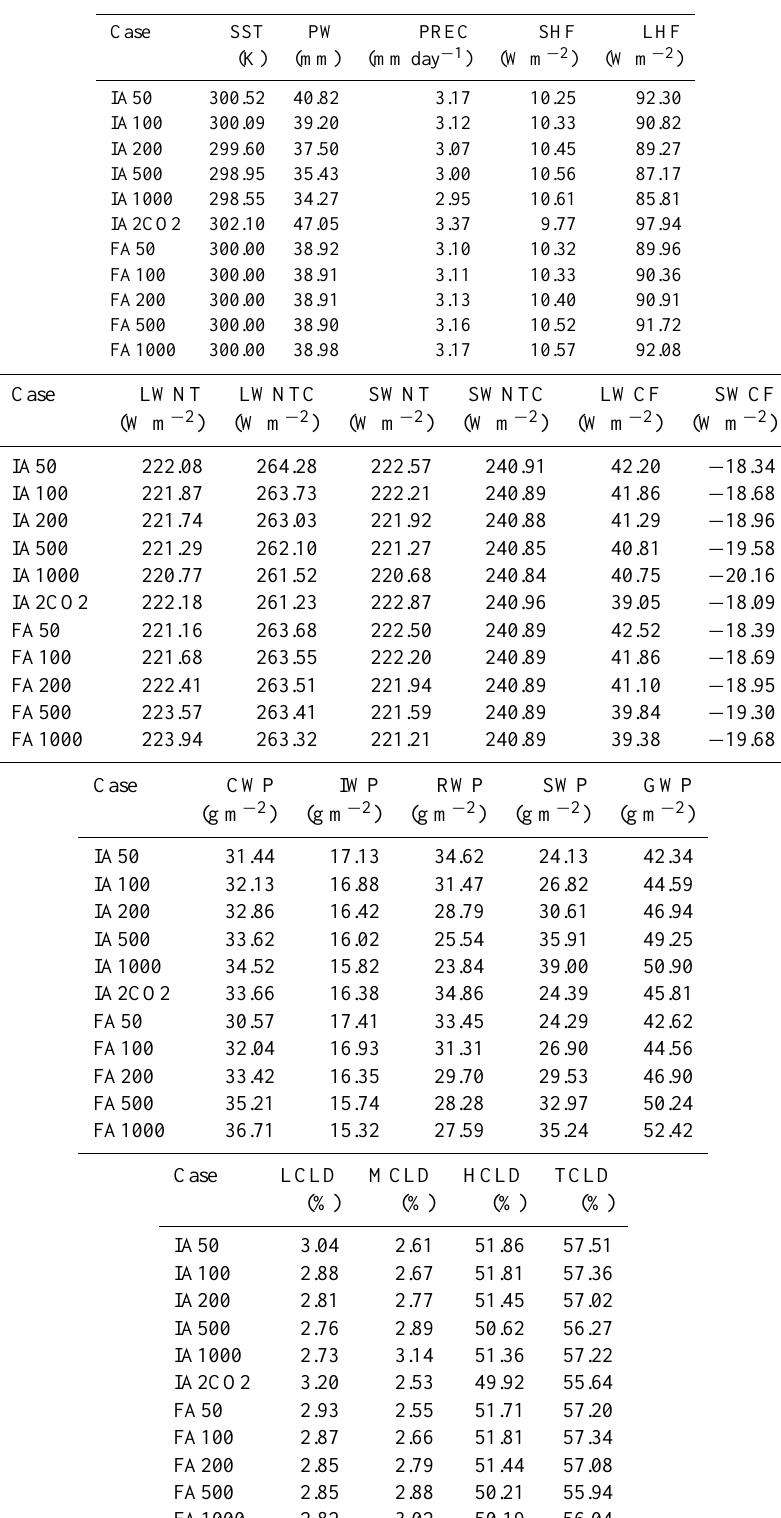
Table 2. Simulation results (see Table 3 for the list of